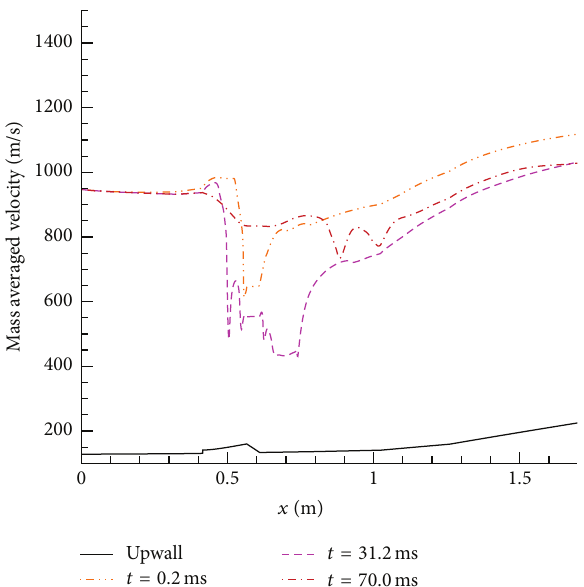
Figure 17: Mass averaged velocity of the scramjet combustor with and without air throttling at 𝑡 = 70.0